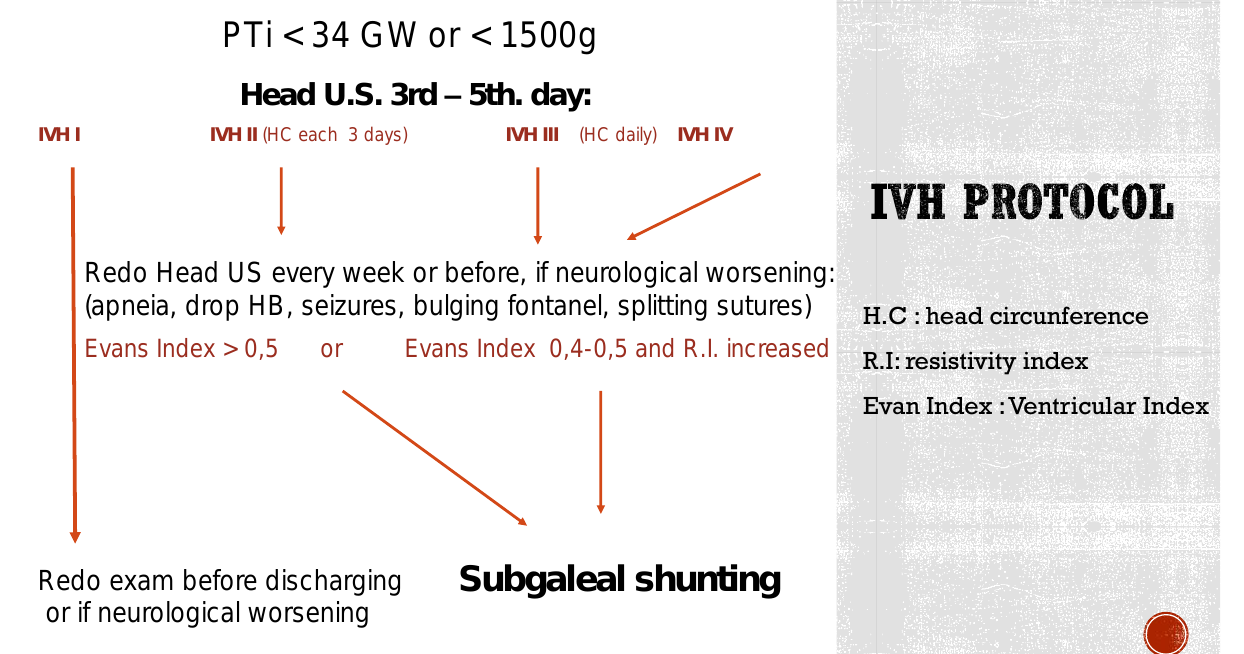
Figure 1 . IVH Protocol